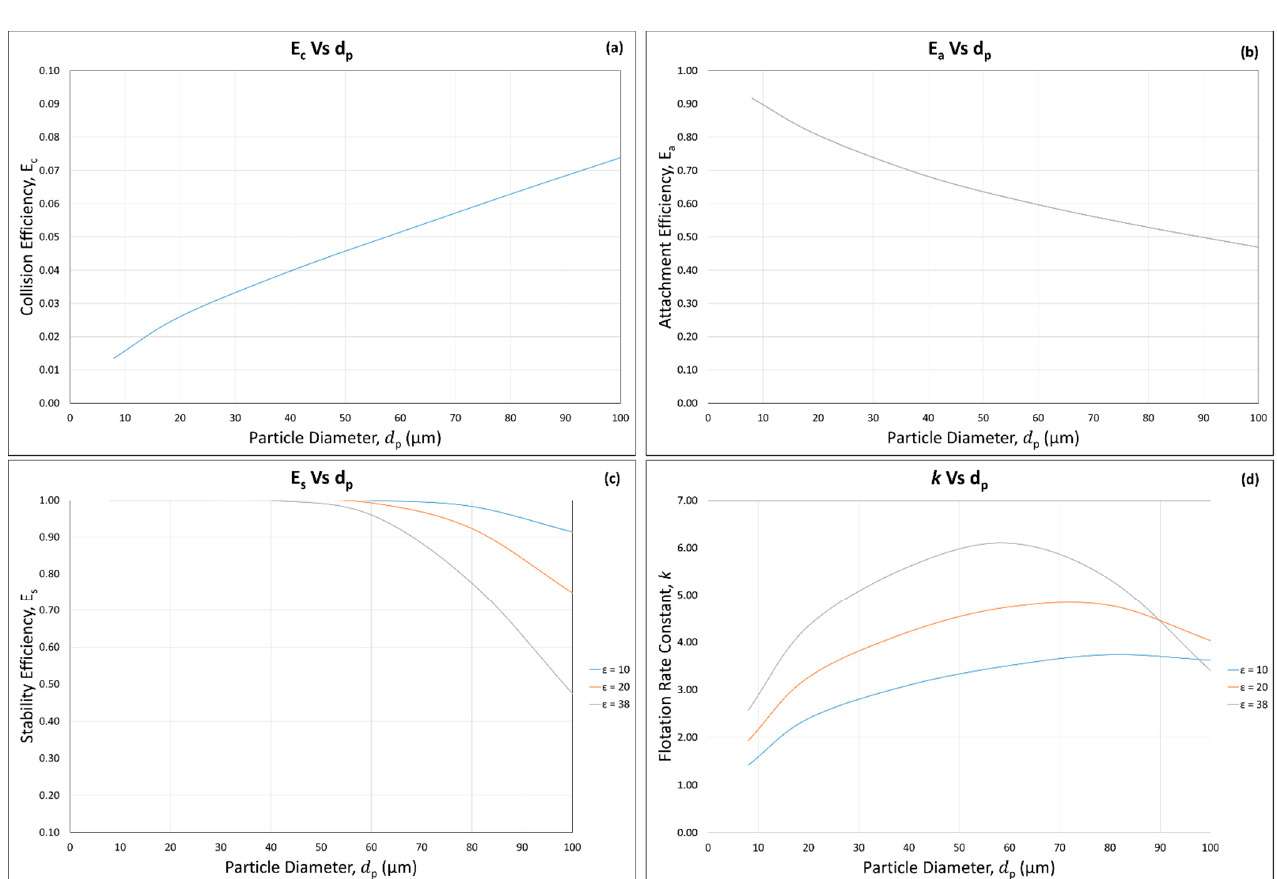
Figure A1. Calculated ( a ) collision ( E c ) , ( b ) attachment ( E a ) , and ( c ) stability ( E s ) efficiencies as well as ( d ) flotation rate constant ( k ) as a function of particle diameter d p and dissipation energy ( ε ) (10, 20, and 38 m 2 s − 3 ), ( d b = 0.0014 m, ρ p = 2650 kg m − 3 , v b = 0.18 m s − 1 , ϕ = 80 ◦ , µ = 0.001 N s m − 2 ).